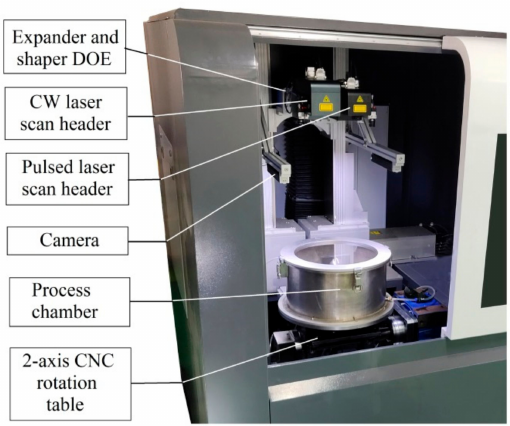
Figure 6. Five-axis CNC device with dual-beam.